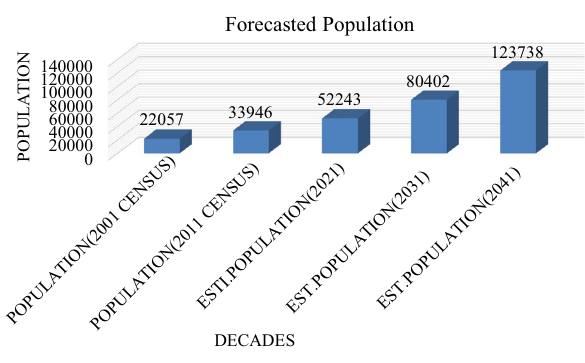
Fig. 2 Graphical representation of forecasted population along with previous